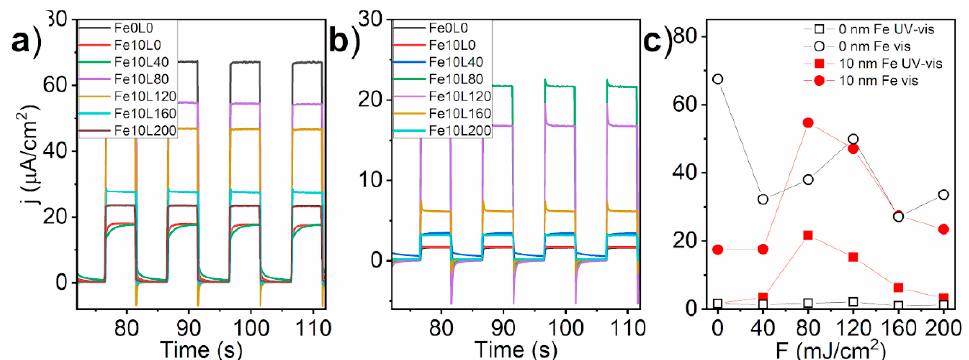
Figure 11. Transient photocurrents recorded for the bare and laser-annealed Fe-decorated TiO 2 -NTs in 0.5 M NaOH electrolyte under the light of full solar ( a ) and limited to visible ( b ) spectrum. Light-on current plateau of chronoamperometry records in UV-vis (circle) and visible light (square) are shown in graph ( c ).